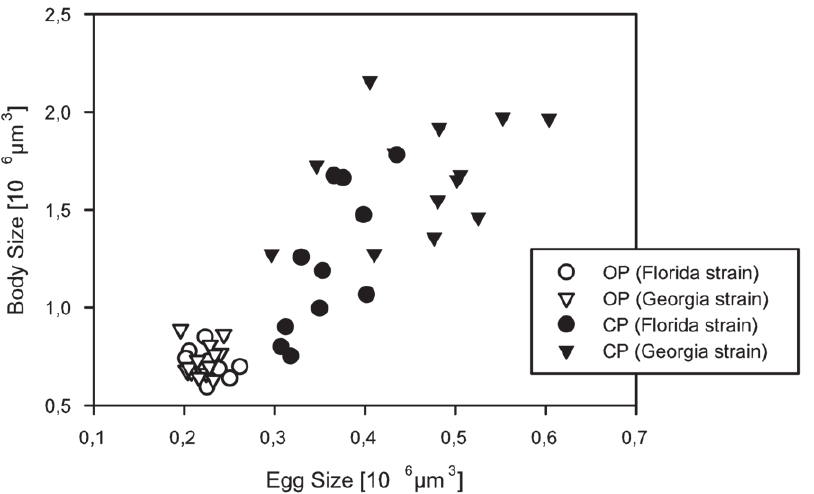
Figure 2. Dwarfing in obligate parthenogenogenetic clones of the rotifer Brachionuscalyciflorus . Each symbol represents the mean value of egg size and female body size for different clone (Sample sizes for each clone: Eggs: n=24 6 1.4; Females: n=15 6 0.9; mean 6 s.e.m.). Open symbols: obligate parthenogenetic clones (OP); closed symbols: cyclical parthenogenetic clones (CP), Circles: clones of the Florida strain; Triangles: clones of the Georgia strain. In total, 40 clones were analyzed (23 OP and 17 CP).